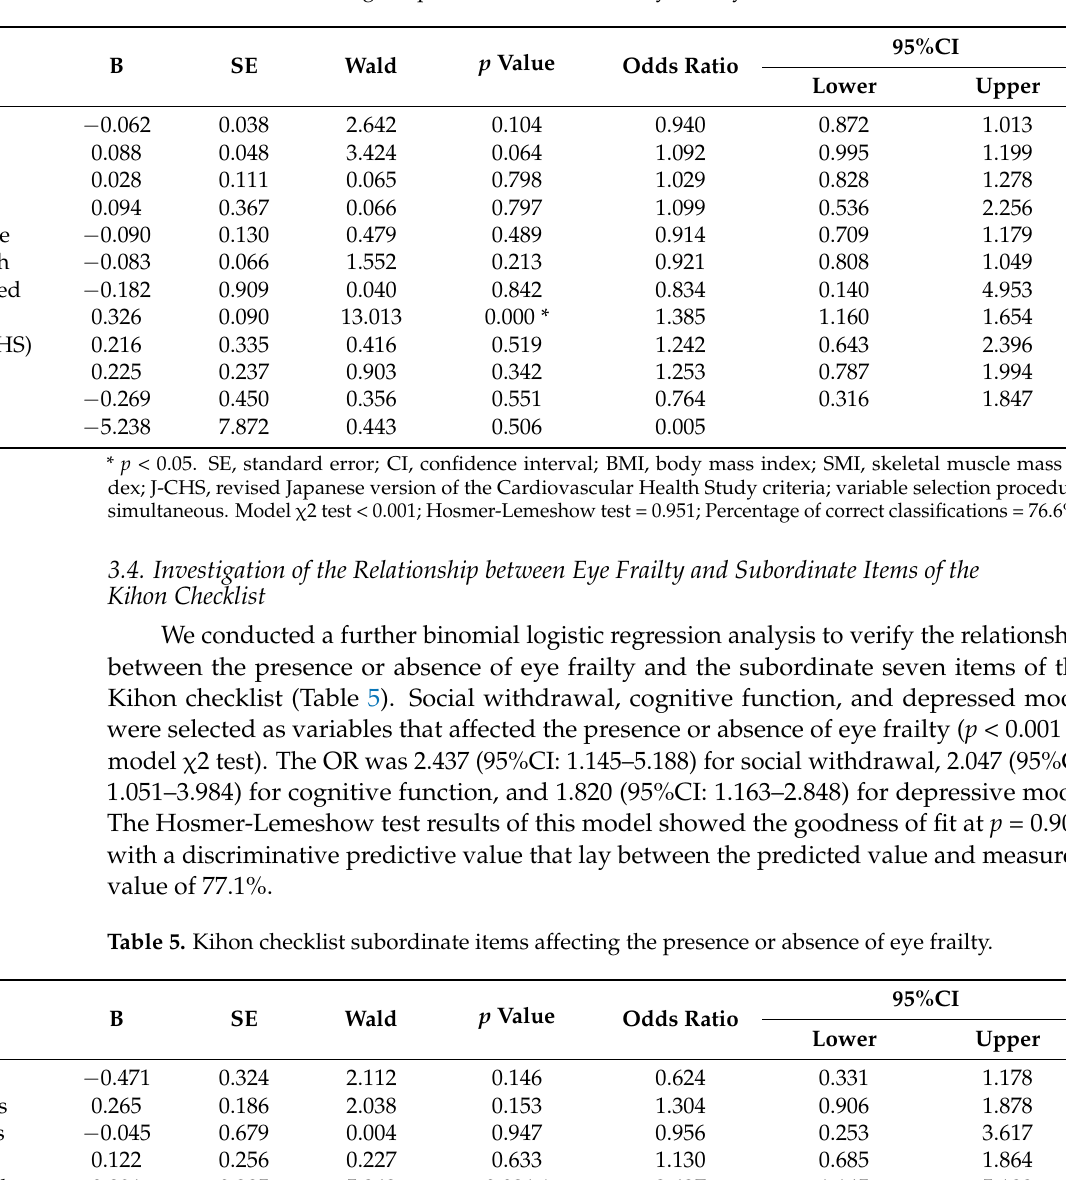
Table 4. Variables affecting the presence or absence of eye frailty.